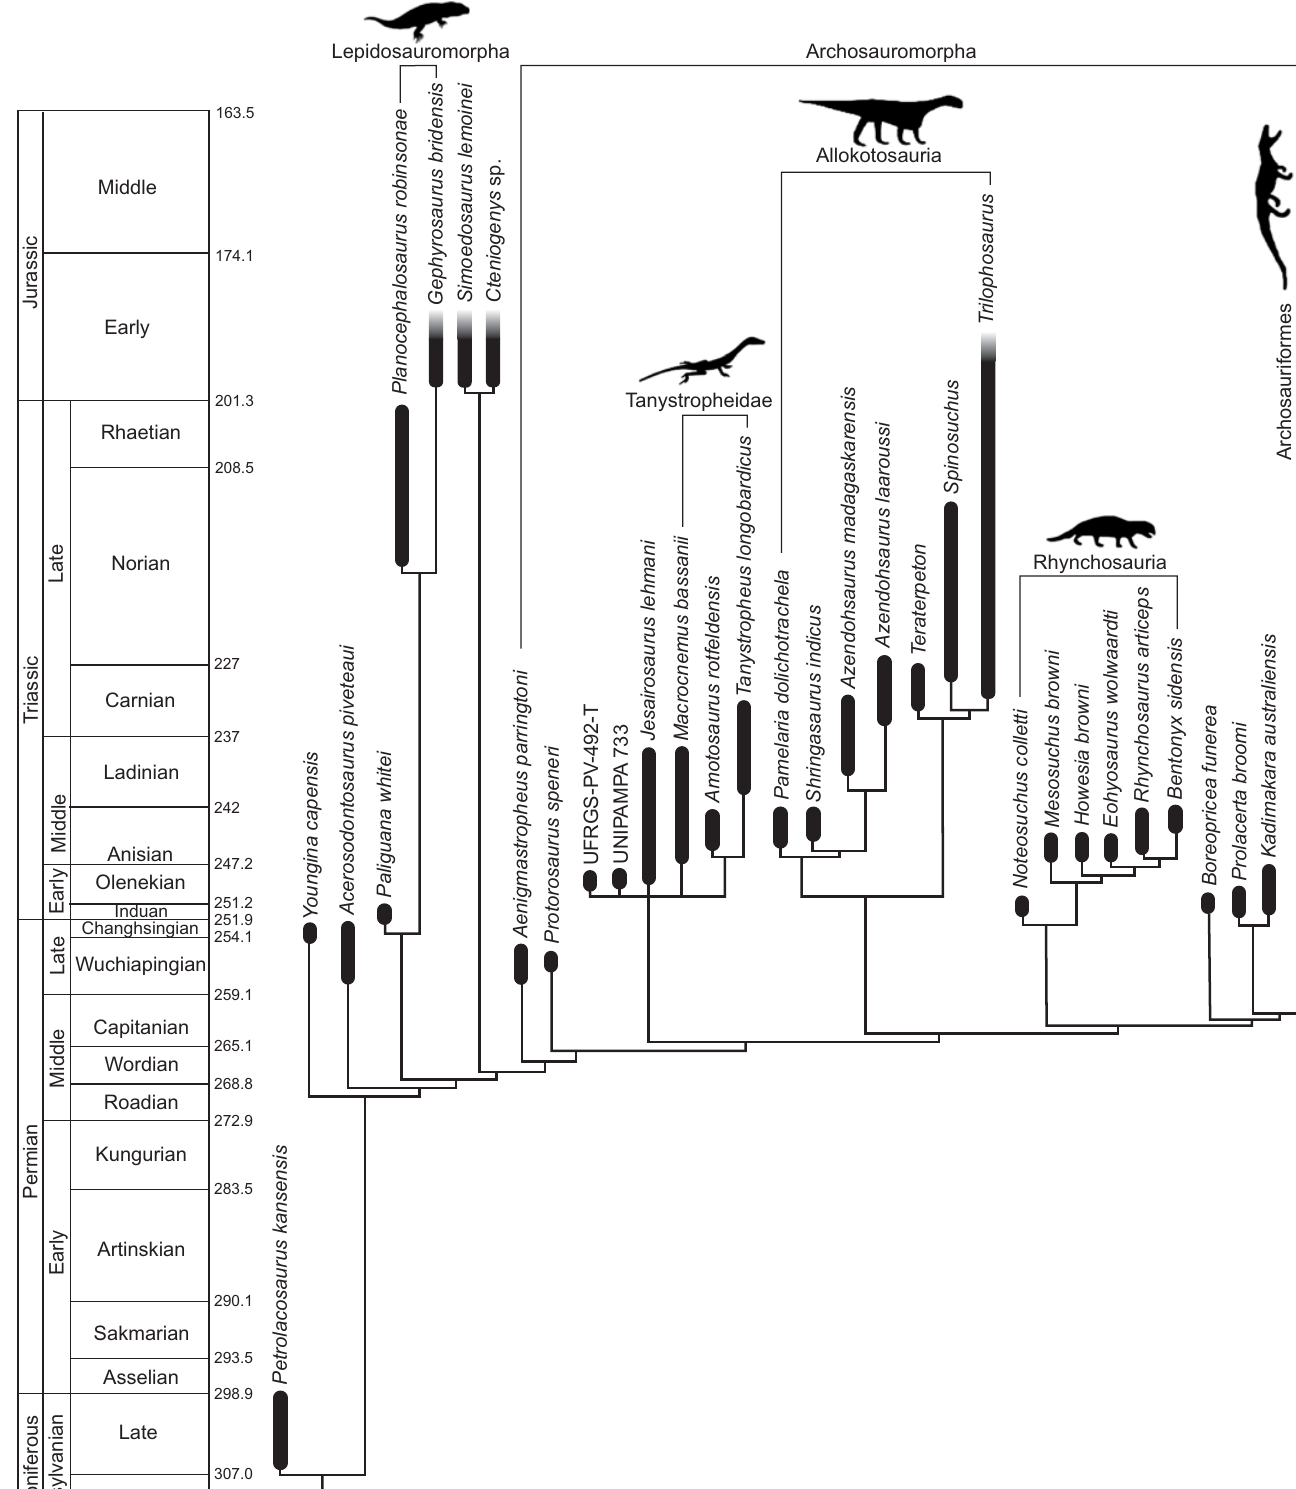
Fig. 4. Strict consensus of the analysis including UNIPAMPA 733 and UFRGS-PV- 492-T (analysis ii) based on the reduced matrix of Sengupta et al.